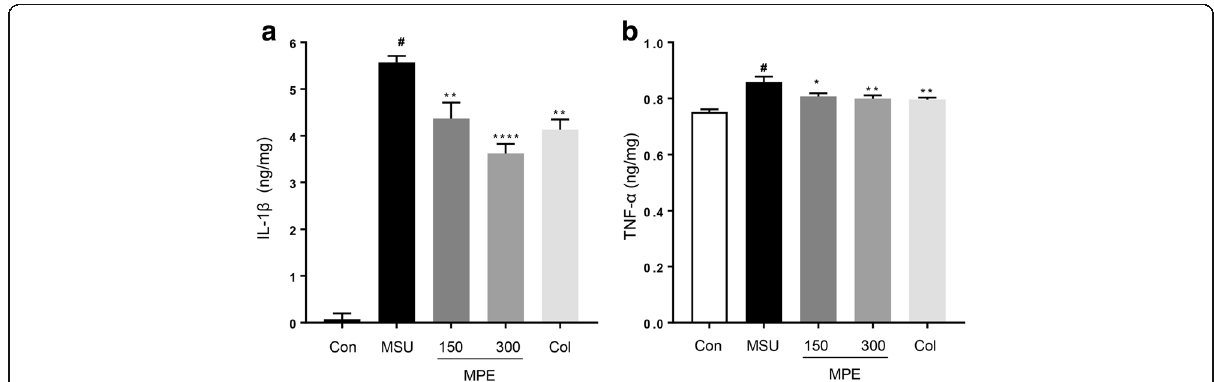
Fig. 3 Effects of MPE on expression levels of inflammatory cytokines in MSU crystal-induced gouty arthritis in mouse paw tissue. Con, control mice; MSU, MSU crystal-induced mice; MPE, MSU mice treated with 150/300 mg/kg of MPE; Col, MSU mice treated with 1 mg/kg of colchicine. a IL-1 β and b TNF- α levels were measured by ELISA. Data are presented as the mean ± SEM ( n = 5). # p < 0.0001 vs. control group; * p < 0.05, ** p < 0.01 and **** p < 0.0001 vs. MSU group